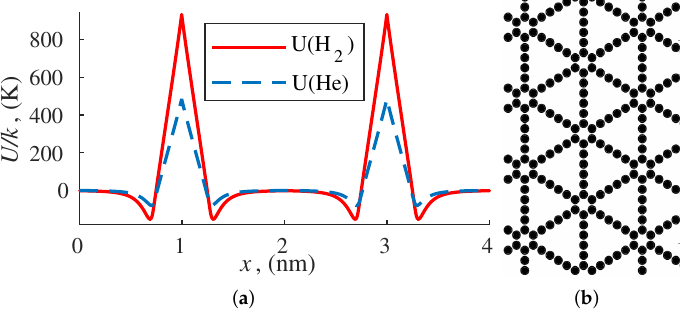
Figure 2. The potential energy of interaction of a bilayer graphdiyne membrane with helium and hydrogen ( a ); the structure of graphdiyne ( b